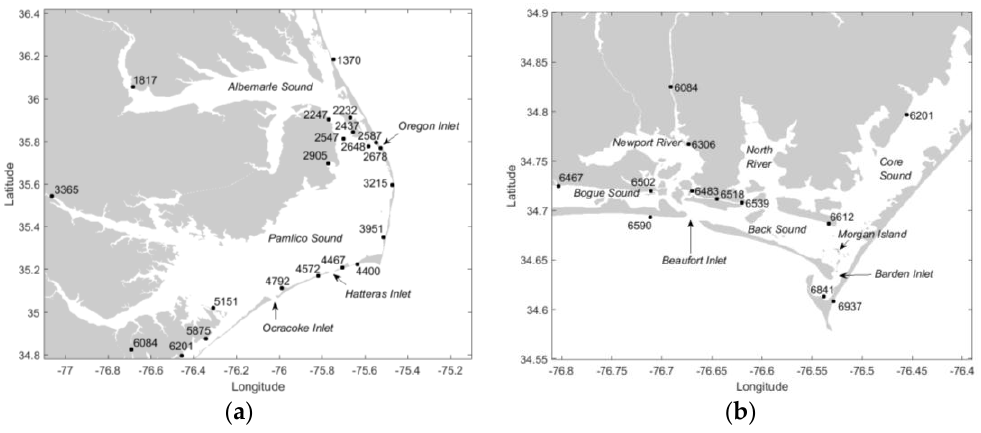
Figure 1. Map of North Carolina coastal waters and inlets and the locations of the National Oceanic and Atmospheric Administration (NOAA) water level stations (black dots): ( a ) Northern part; ( b ) Southern part. Please note that the scale in ( b ) is 4 times larger than ( a ).